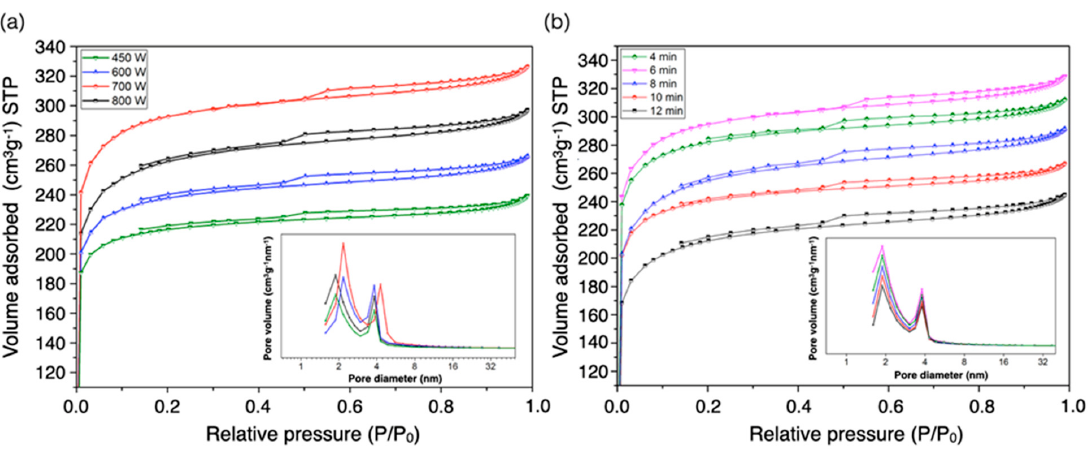
Figure 4. N 2 adsorption and desorption isotherms and pore size distribution curves of PMFCs obtained at varied ( a ) microwave radiation powers and ( b ) activation holding times.